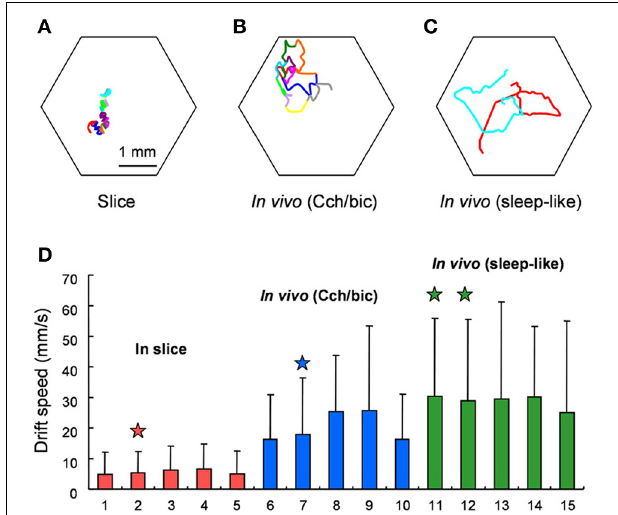
FIGURE 5 | Behavior of spiral waves in mammalian visual cortex under various conditions. From the original; Drifting of Spiral Phase Singularities. (A) Trajectory of spiral phase singularity during a 12-cycle spiral waves in cortical slices. (B) Trajectory of spiral phase singularity during an 11-cycle spiral waves in vivo under Cch/bic application. Hexagon shows the field of view and each color represents one cycle of spiral wave. (C) Trajectory of spiral phase singularities during 2 spiral waves (red and cyan, each with 1.5 turn) during sleep-like states. (D) Comparison of drifting speed of spiral phase singularity for slices and in vivo . Five examples from in vivo under Cch/bic, in vivo during sleep-like states and slices, respectively, are shown (mean + SD ). Columns with stars on top are from the examples in (A,C) . The standard deviation is large because the drifting of spiral phase singularity is not consistent and there are large variations from time to time. The difference between in vivo and slices is statistically significant (Welch’s test, p < 0 . 001, 25 t tests). The difference between in vivo (Cch/bic) and in vivo (sleep-like) is also significant. Reprinted from Figure 7 in Huang et al. (2010), copyright Elsevier